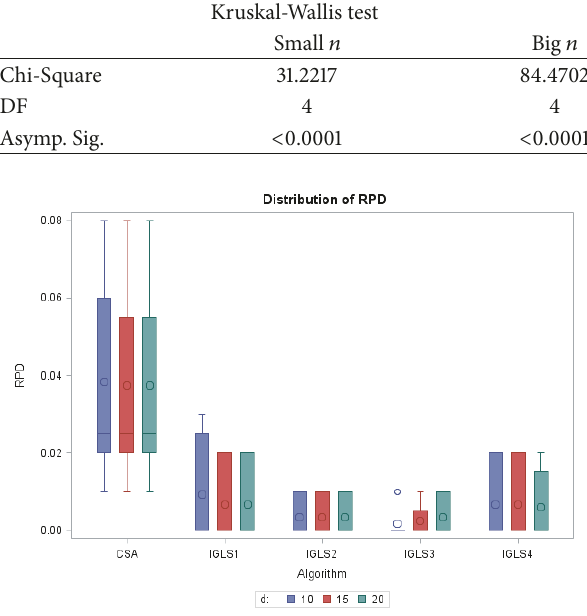
Figure 2: Boxplots of RPD for